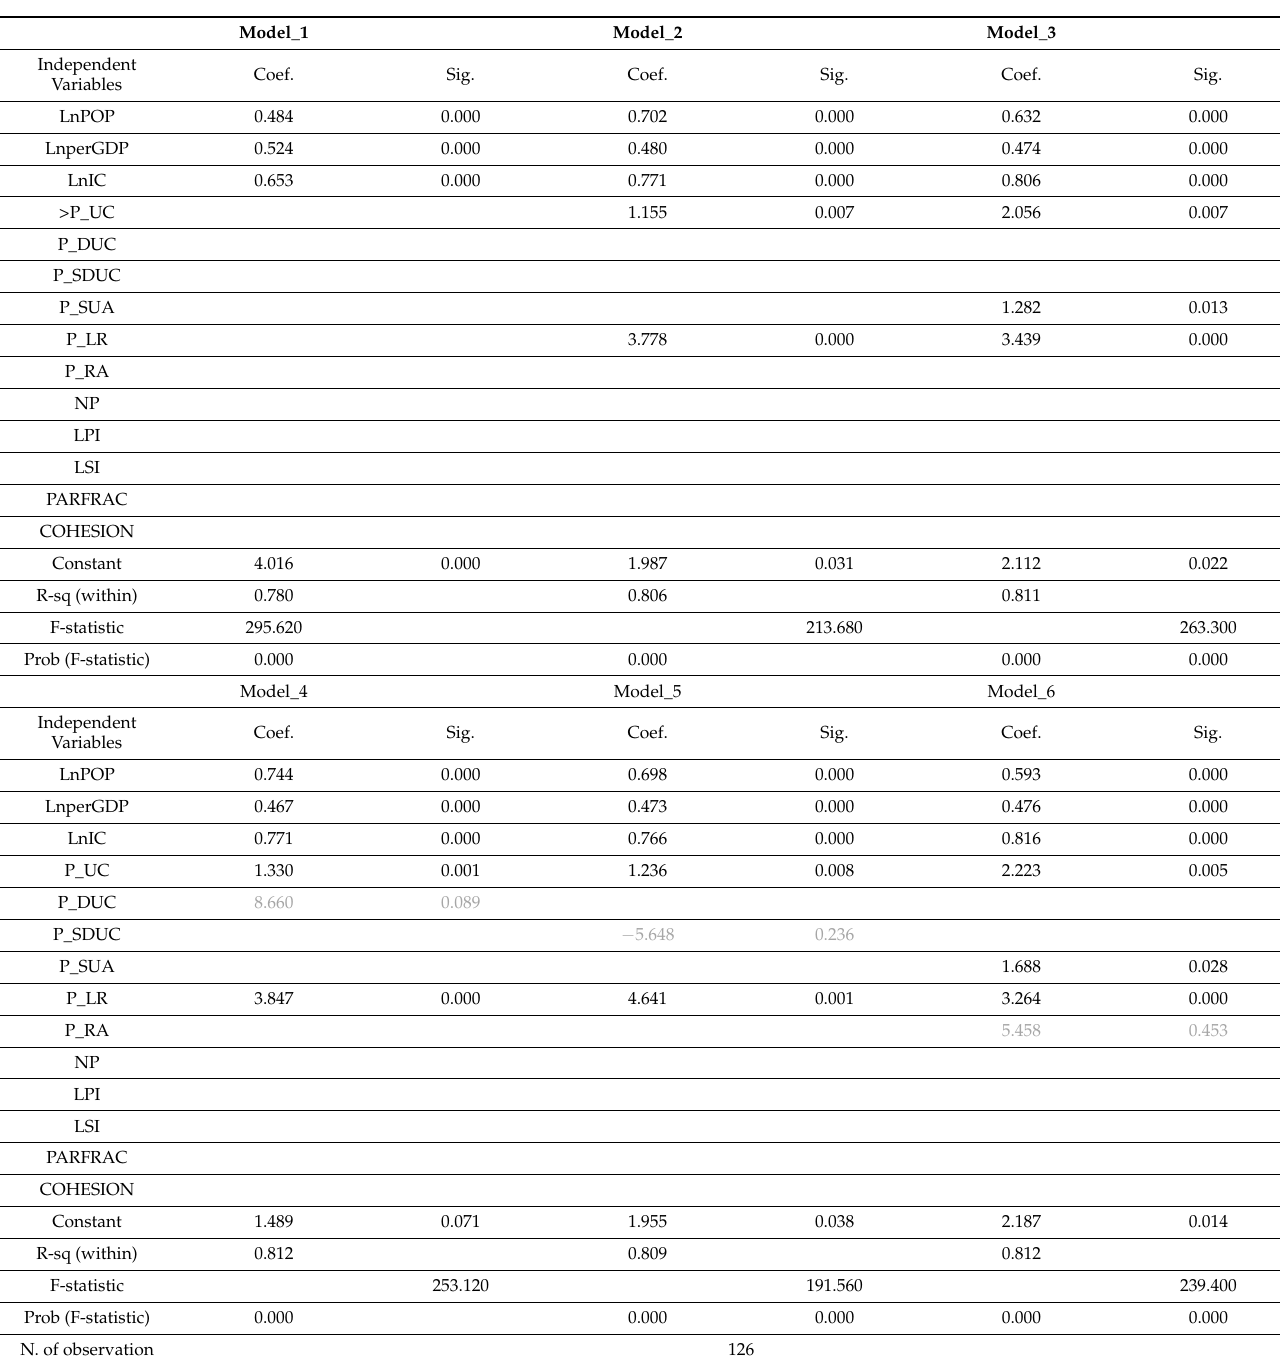
Table 5. Model results of GHG emissions and urban-rural